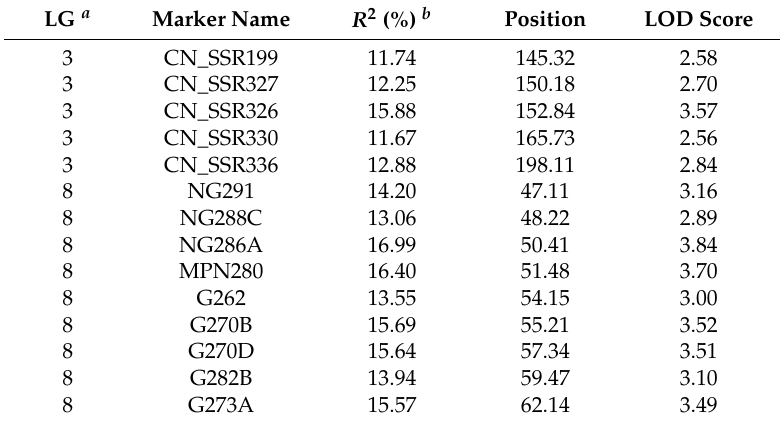
Figure 4. Log of the odds (LOD) graph of the quantitative trait loci (QTL) qPE3.1 ( A ) and qPE8.1 ( B ) controlling seed phorbol esters content detected in the F 2 population of Chai Nat × M10 by inclusive composite interval mapping. Table 1. Simple sequence repeat (SSR) markers associated with seed phorbol esters content in F 2 population of Chai Nat × M10 detected by likelihood ratio test method. Log of the odds (LOD) value of 2.5 was used as a significant threshold.